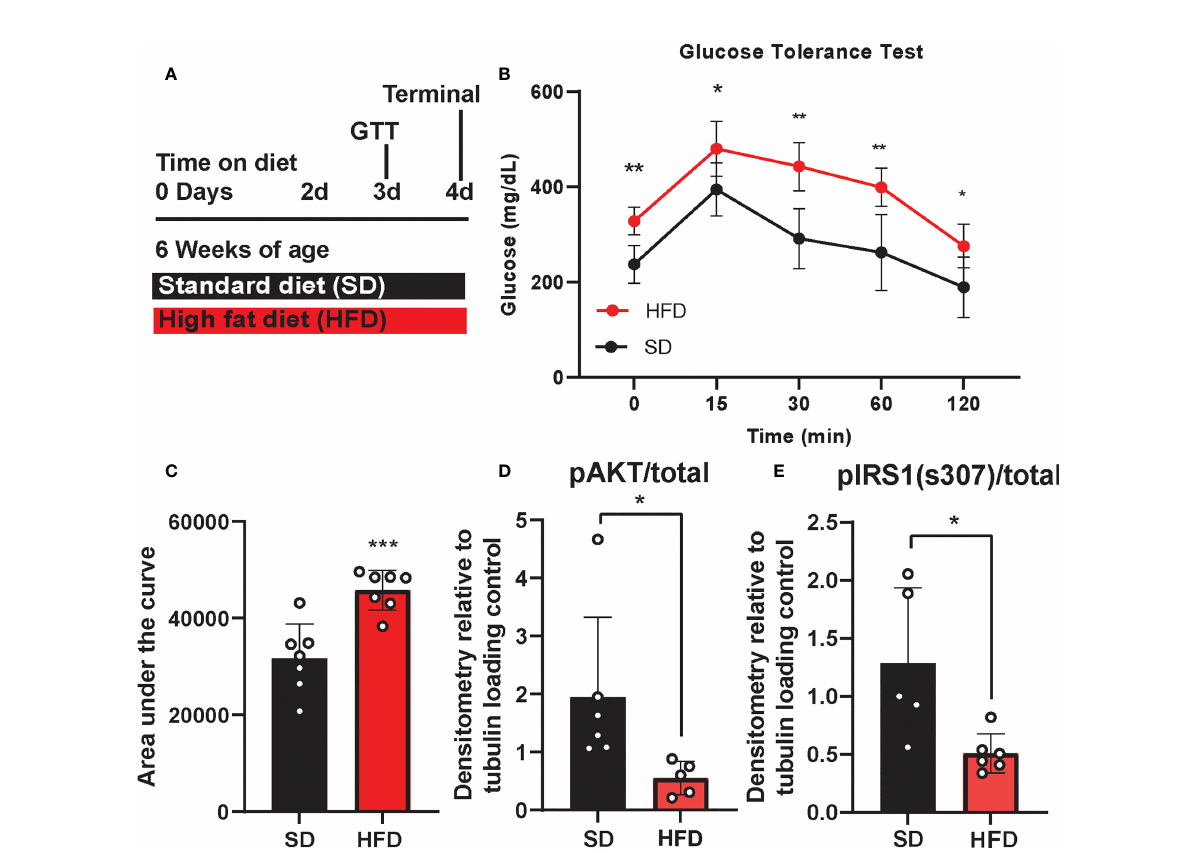
FIGURE 1 Experimental timeline and metabolic phenotyping. Experimental timeline (A) , glucose tolerance test, (GTT; B ), area under the curve (C) , and cortex response to insulin stimulation (D, E) in male BL/6 mice fed standard diet (SD) or high fat diet (HFD). Protein expression normalized to tubulin and relative to unstimulated control; * p <0.05, ** p <0.01, *** p